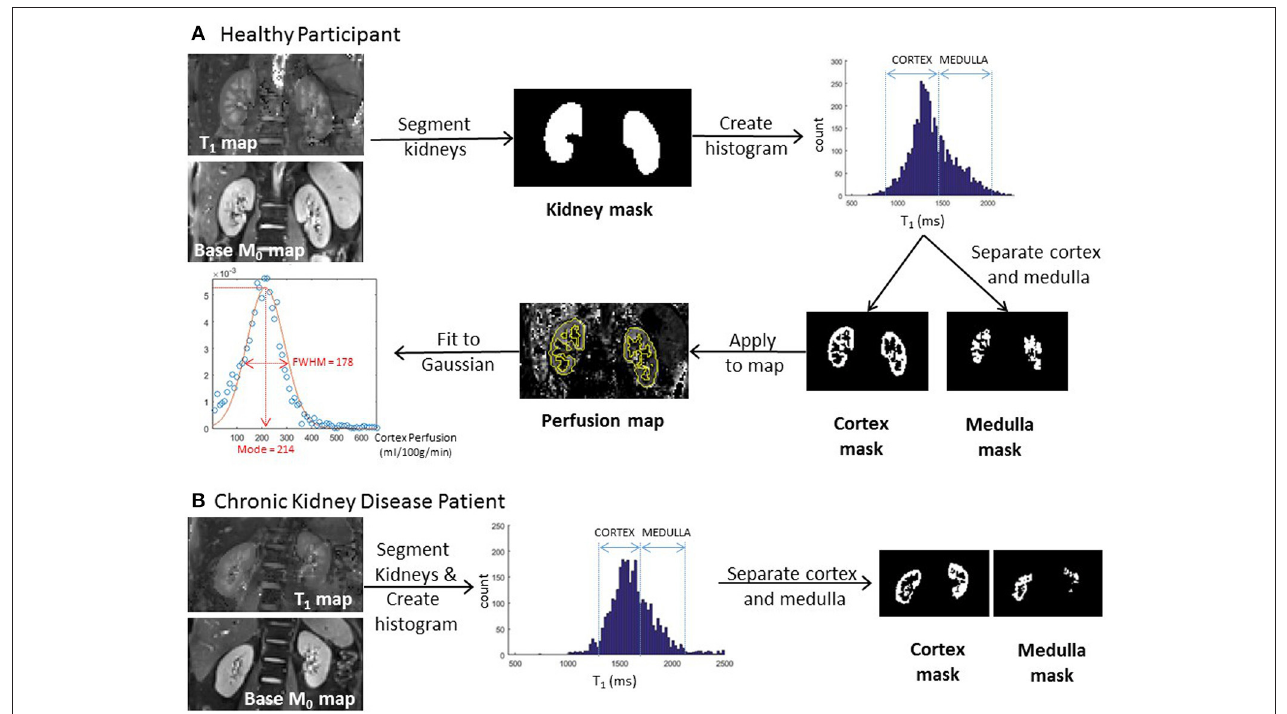
FIGURE 3 | (A) Example image analysis for a healthy participant indicating segmentation of the kidneys from the T 1 map, definition of cortex and medulla masks from the histogram, and the application of the renal cortex mask to an arterial spin labeling perfusion map allowing the interrogation of a histogram [for mode and full-width-at-half-maximum (FWHM)] of renal cortex perfusion values. (B) Example image analysis for a chronic kidney disease patient indicating definition of cortex and medulla masks from the T 1 histogram of the